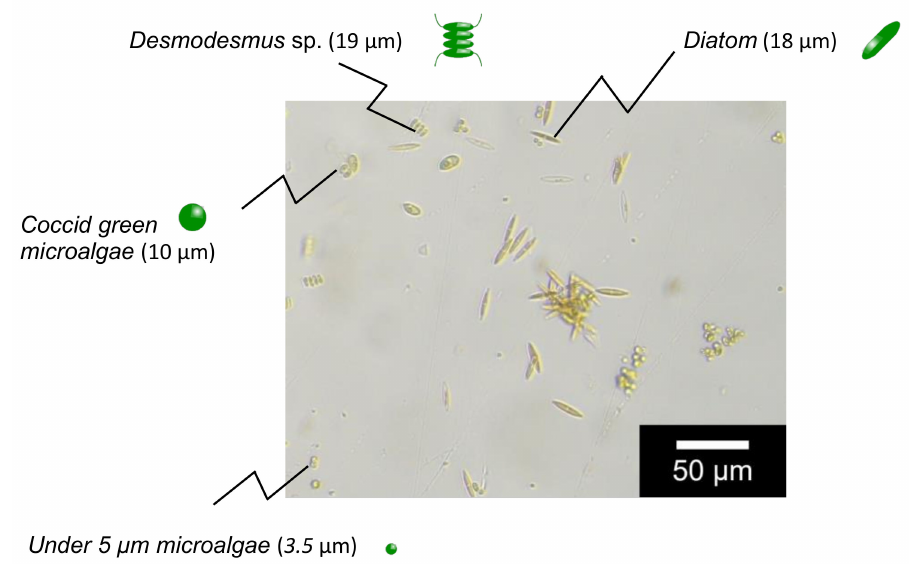
Figure 2. Image of target microalgae.